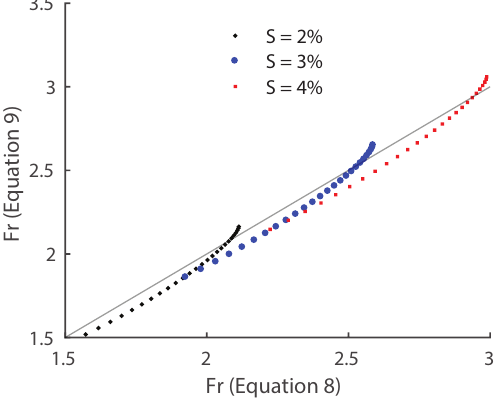
Figure 7. A comparison of Fr 1 values between Equation (8) (the current study) and Equation (9) (Hager